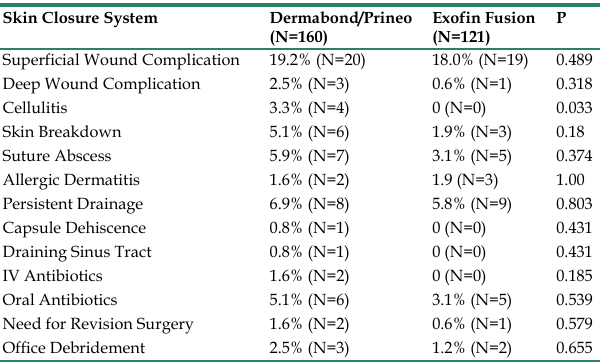
Table 1. Primary Outcomes: Superficial and Deep Wound Complications Skin Closure System